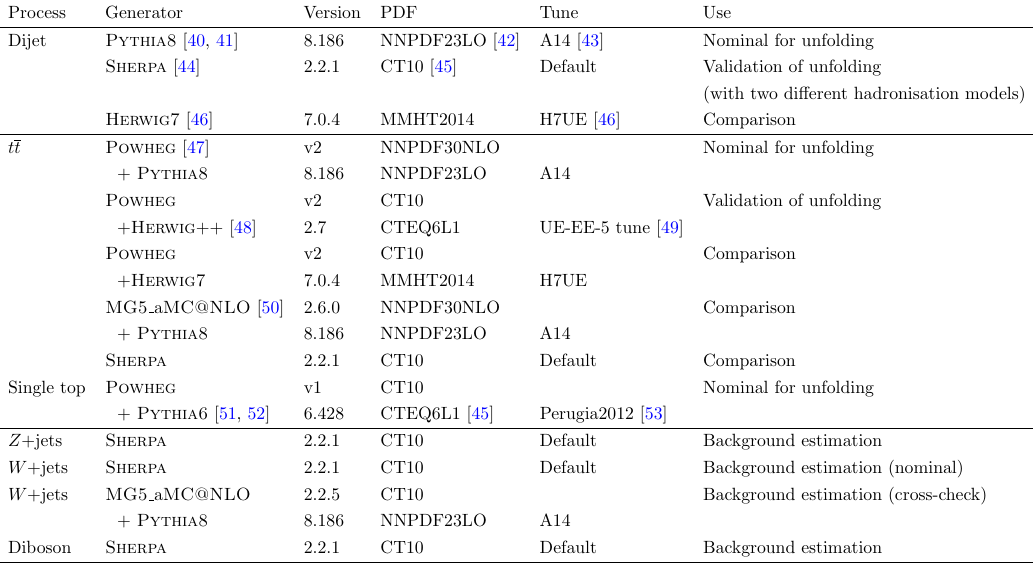
Table 1 . Main features of the Monte Carlo models used to simulate signal and background samples, and to produce predictions to be compared with data. The nominal samples listed are used for comparisons with corrected data at particle level as well. For convenience, MG5 a MC@NLO is referred to as MG5 aMC in (cid:12)gures